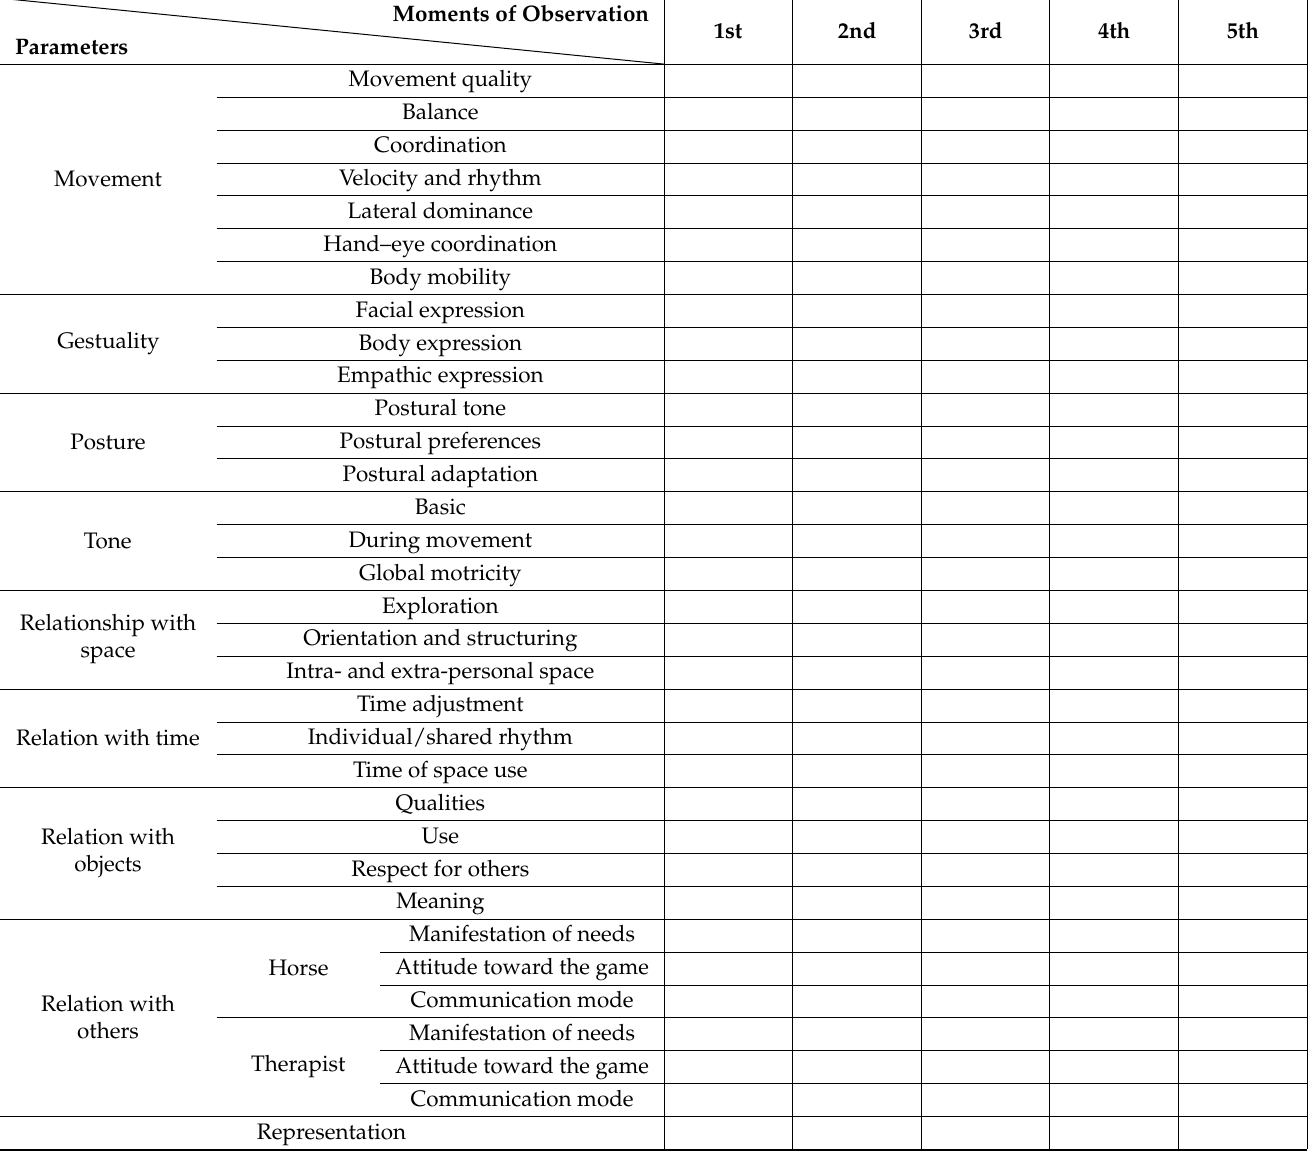
Table A1. Individual psychomotor observation